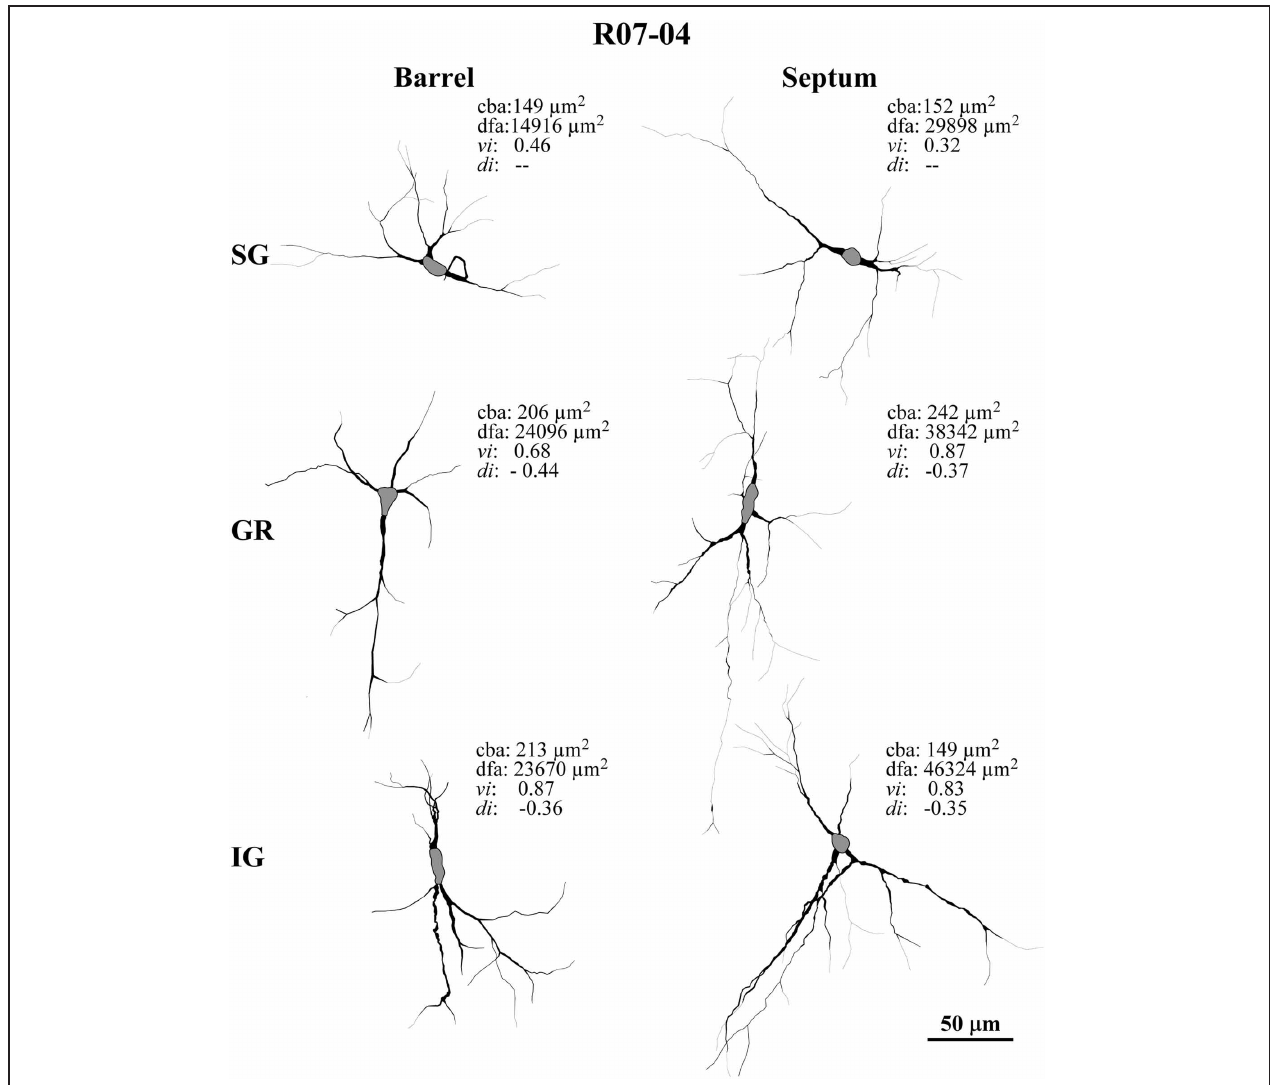
FIGURE 2 | Examples of typical nitrergic neurons from different cortical compartments in case R07-04 that were 3D-reconstructed in Neurolucida. All neurons are oriented as if the pia mater were parallel to the top of the figure. Barrel and septal neurons are represented respectively in the left and right columns of the figure. Accordingly, neurons in top, middle, and inferior rows of the figure were respectively located in supragranular (SG), granular (GR), and infragranular (IG) compartments. Neurons in GR and